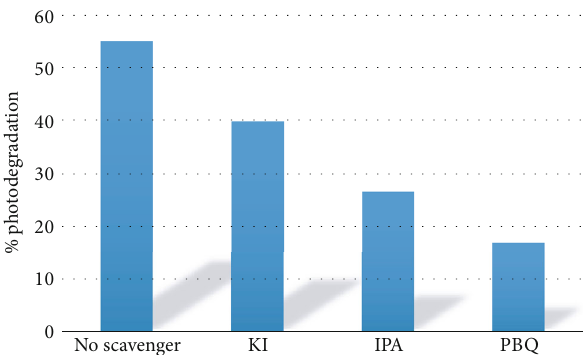
Figure 10: Result of MB photodegradation in the presence of reactive oxygen species scavengers, after 120 minutes under visible irradiation on ZnO:Ag (5%) thin fi